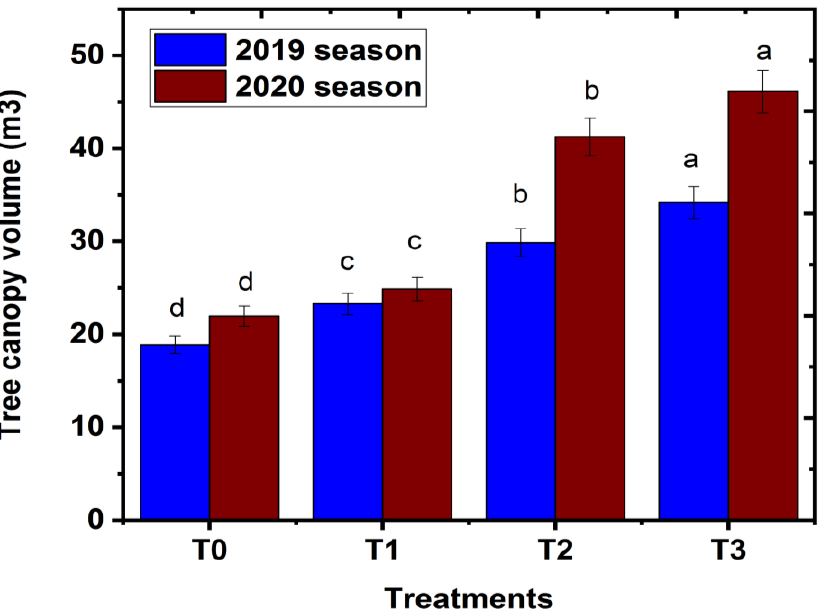
Figure 1. Effect of magnetic iron application on tree canopy volume (cm 3 ) of ‘Chinese’ mandarin trees during 2019 and 2020 seasons. T0: 0 g magnetic iron.tree − 1 , T1: 250 g magnetic iron.tree − 1 , T2: 500 g magnetic iron.tree − 1 , and T3: 750 magnetic iron.tree − 1 . Bars indicate mean values ± SE ( n = 9). Different letters above columns indicate significant differences among magnetic iron treatments at p = 0.05 according to Bartlett ’ s test.